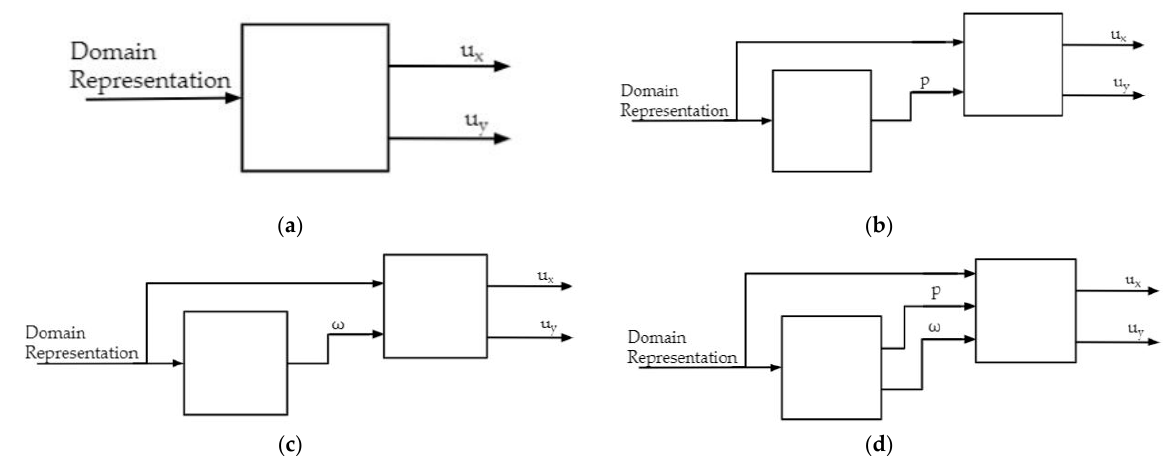
Figure 7. Studied ANN structures. ( a ) Basic structure; ( b ) Pressure-based structure; ( c ) Vorticity-based structure; ( d ) Pressure- and vorticity-based structure.